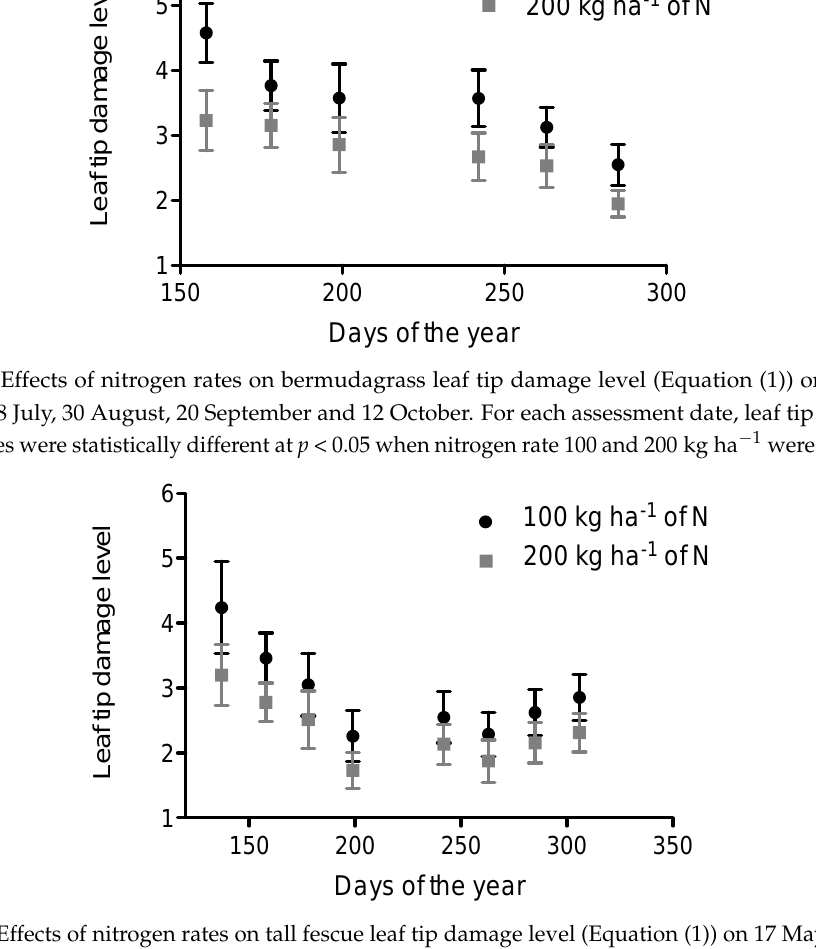
Figure 4. Effects of nitrogen rates on tall fescue leaf tip damage level (Equation (1)) on 17 May, 7 June, 27 June, 18 July, 30 August, 20 September, 12 October and 2 November. For each assessment date, leaf tip damage level values were statistically different at p < 0.05 when nitrogen rate 100 and 200 kg ha − 1 were applied.